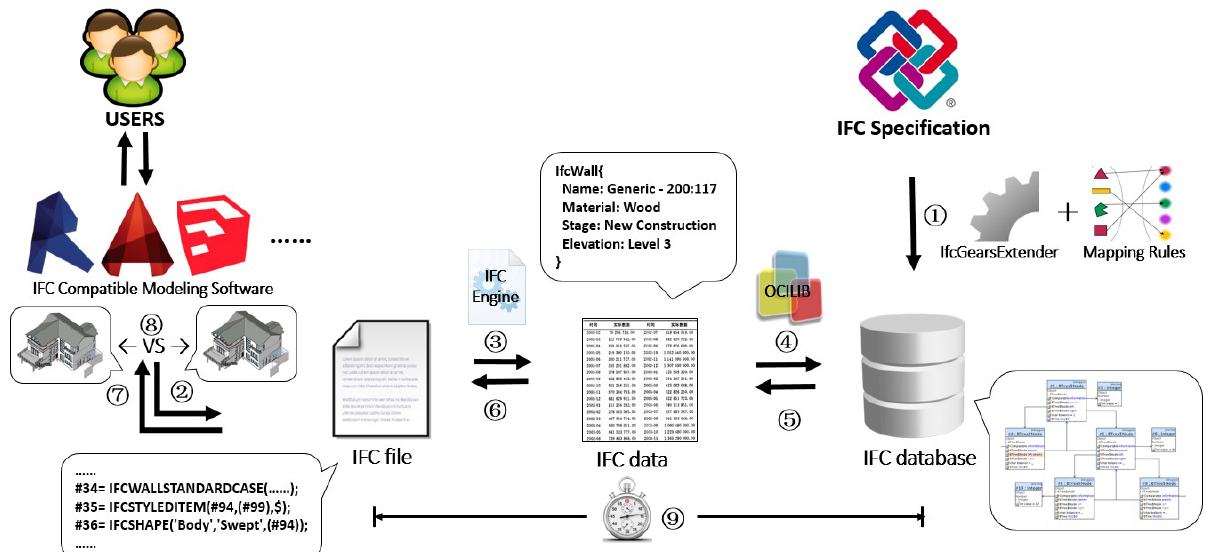
Figure 2. Generation of IFC database and IFC data